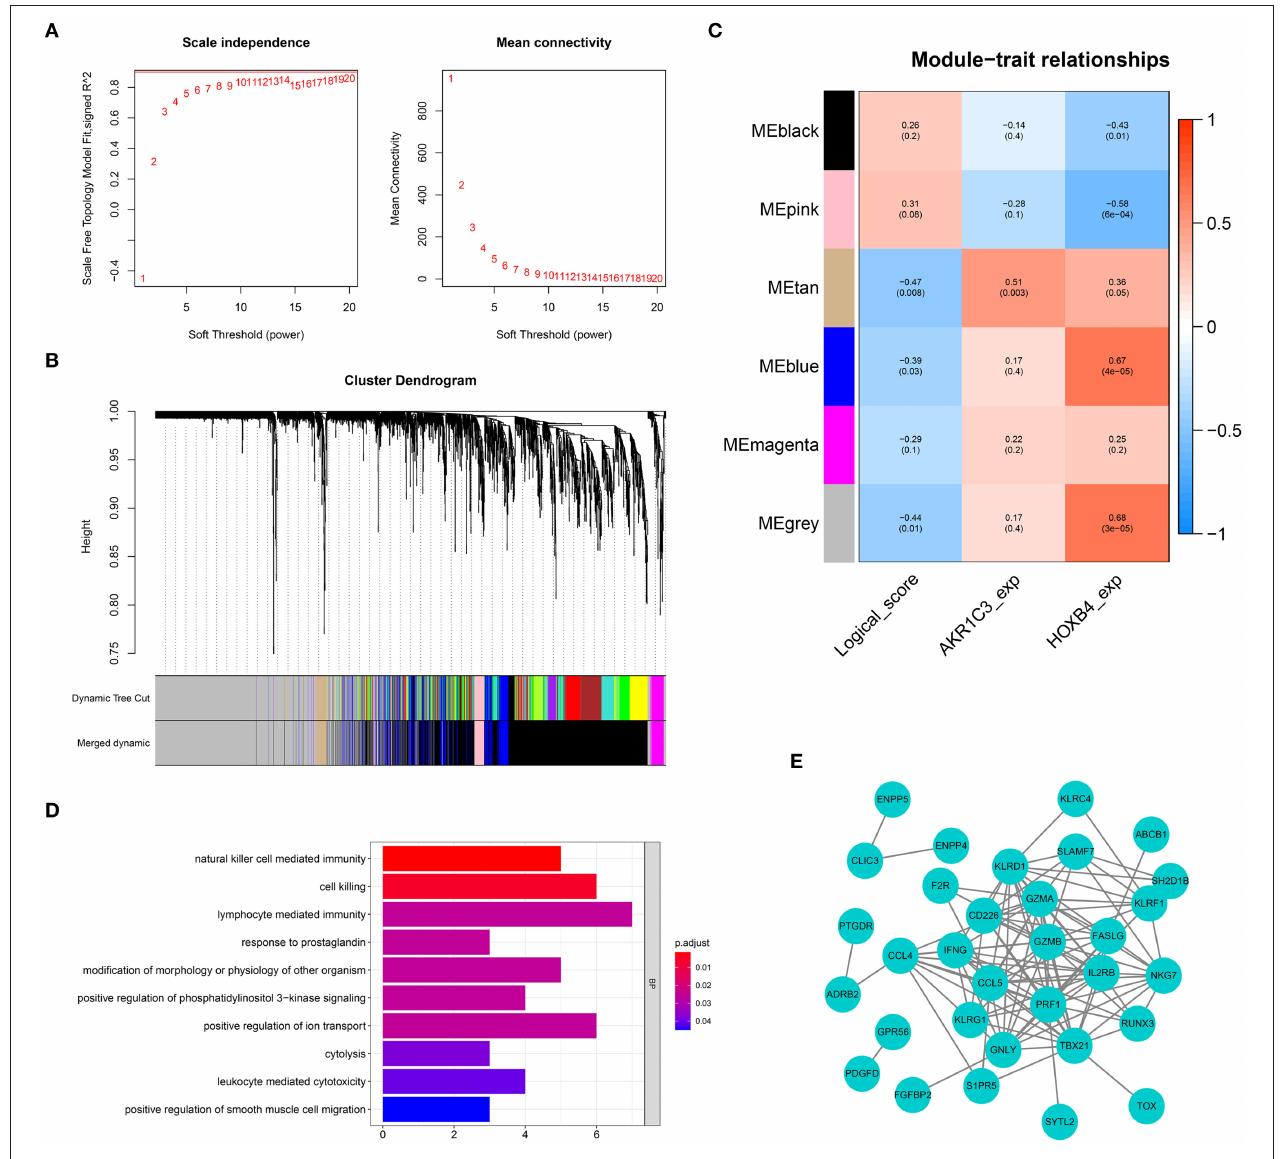
FIGURE 9 | Weighted gene co-expression network analysis. (A) The optimal soft-thresholding value was equal to 19. (B) The genes were divided into six different gene modules. (C) The heat map showing the correlation between logical score and each module. (D) Gene Ontology enrichment. (E) Protein–protein interaction network